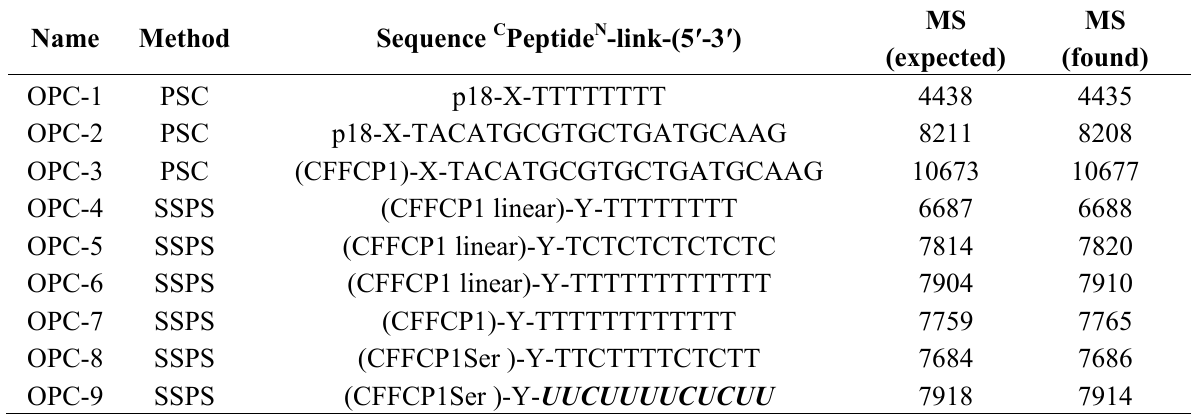
Table 1. Oligonucleotide peptide conjugates prepared in this study.